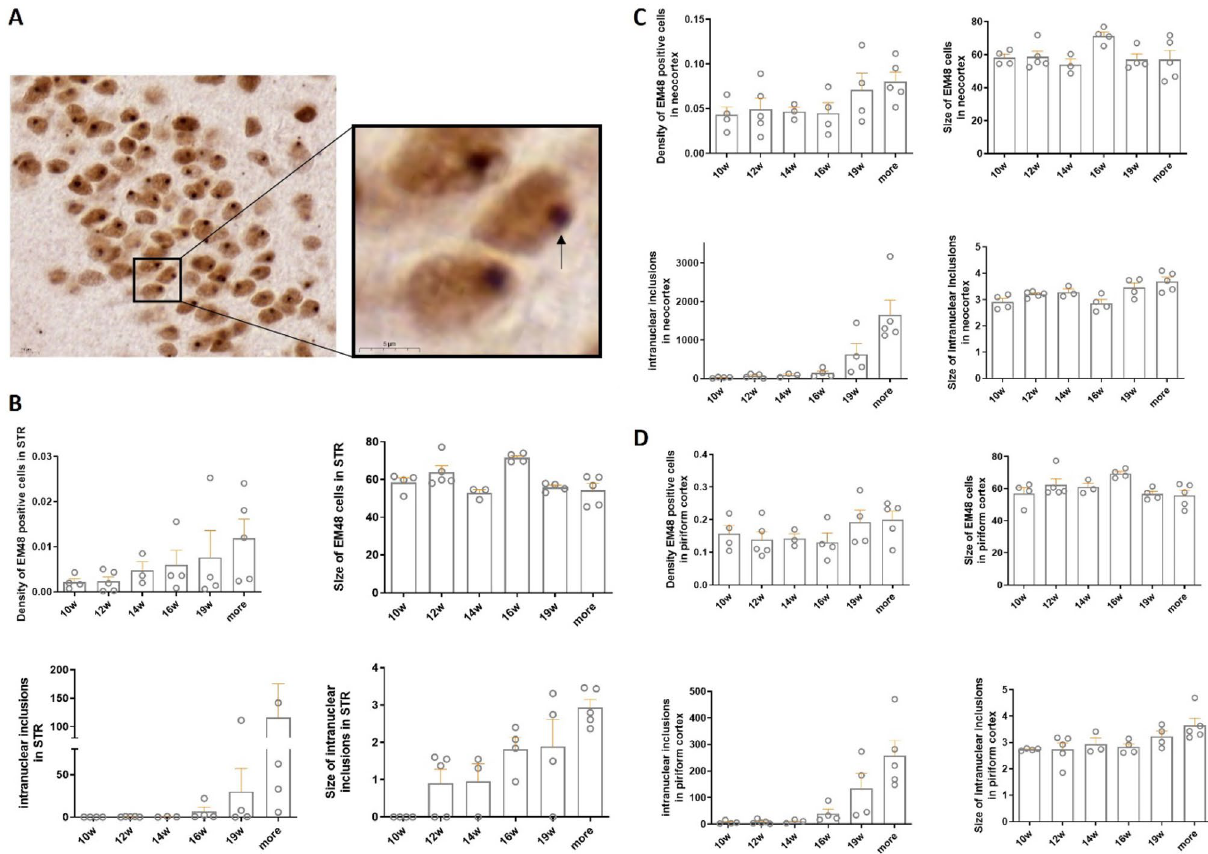
Figure 7. Characterization of development of mHtt aggregates in the N171-82Q mouse model. ( A ) EM48- positive aggregates in N171-82Q mouse model. The black arrow points to the intranuclear inclusion. Magnification: 100×, scale bar = 10 μm. Magnification: 300×, scale bar = 5 μm. Appearance of EM48 positive aggregates in N171-82Q mice was analyzed in six points:10, 12, 14, 16, 19 and more than 19 weeks (between 20 to 30 weeks). ( B ) Development of huntingtin aggregates in striatum. The number of EM48 positive cells, intranuclear aggregates, and size of intranuclear inclusions increased in an age-dependent manner. ( C ) Formation of EM48-labelled aggregates in the neocortex. The number of intranuclear aggregates also increased in the neocortex in an age-dependent manner. ( D ) The number of intranuclear aggregates enhanced in the piriform cortex in an age-dependent manner. The values are expressed as means ± SEM. N = 3–5 animals per